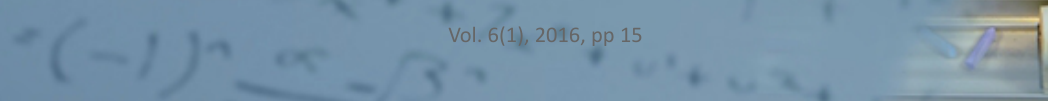
clearly discussed in explicit terms. Table 4. A brief sketch of the significant technological concepts’ state of consideration in